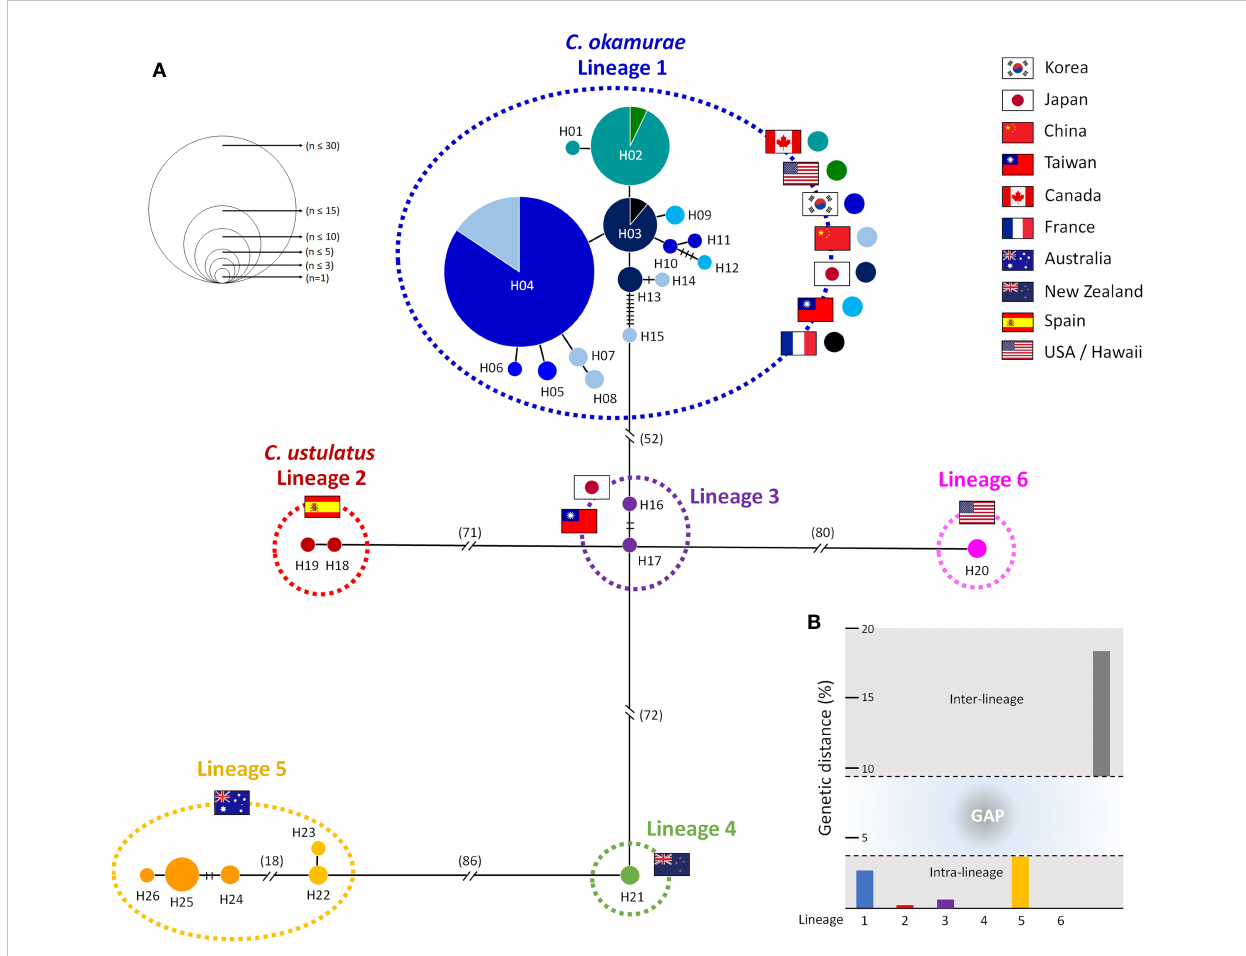
FIGURE 3 Haplotype network and genetic distance for six lineages of Caulacanthus using the COI-5P sequences. In the network (A) , each circle denotes a single haplotype, and each connecting line indicates one mutation step between haplotypes. The size of the circles is proportional to haplotype frequency. The pie chart colors within Lineage 1 correspond to the matching colors next to the fl ag. The cross bars represent the number of mutational steps between two haplotypes when the mutational steps are >1. Flags indicate the country of origin of specimens for each lineage. Minimum and maximum inter-lineage (gray), and intra-lineage (colors refer to lineages de fi ned in the haplotype network) genetic distances ( p -distance) in percent are shown in (B)